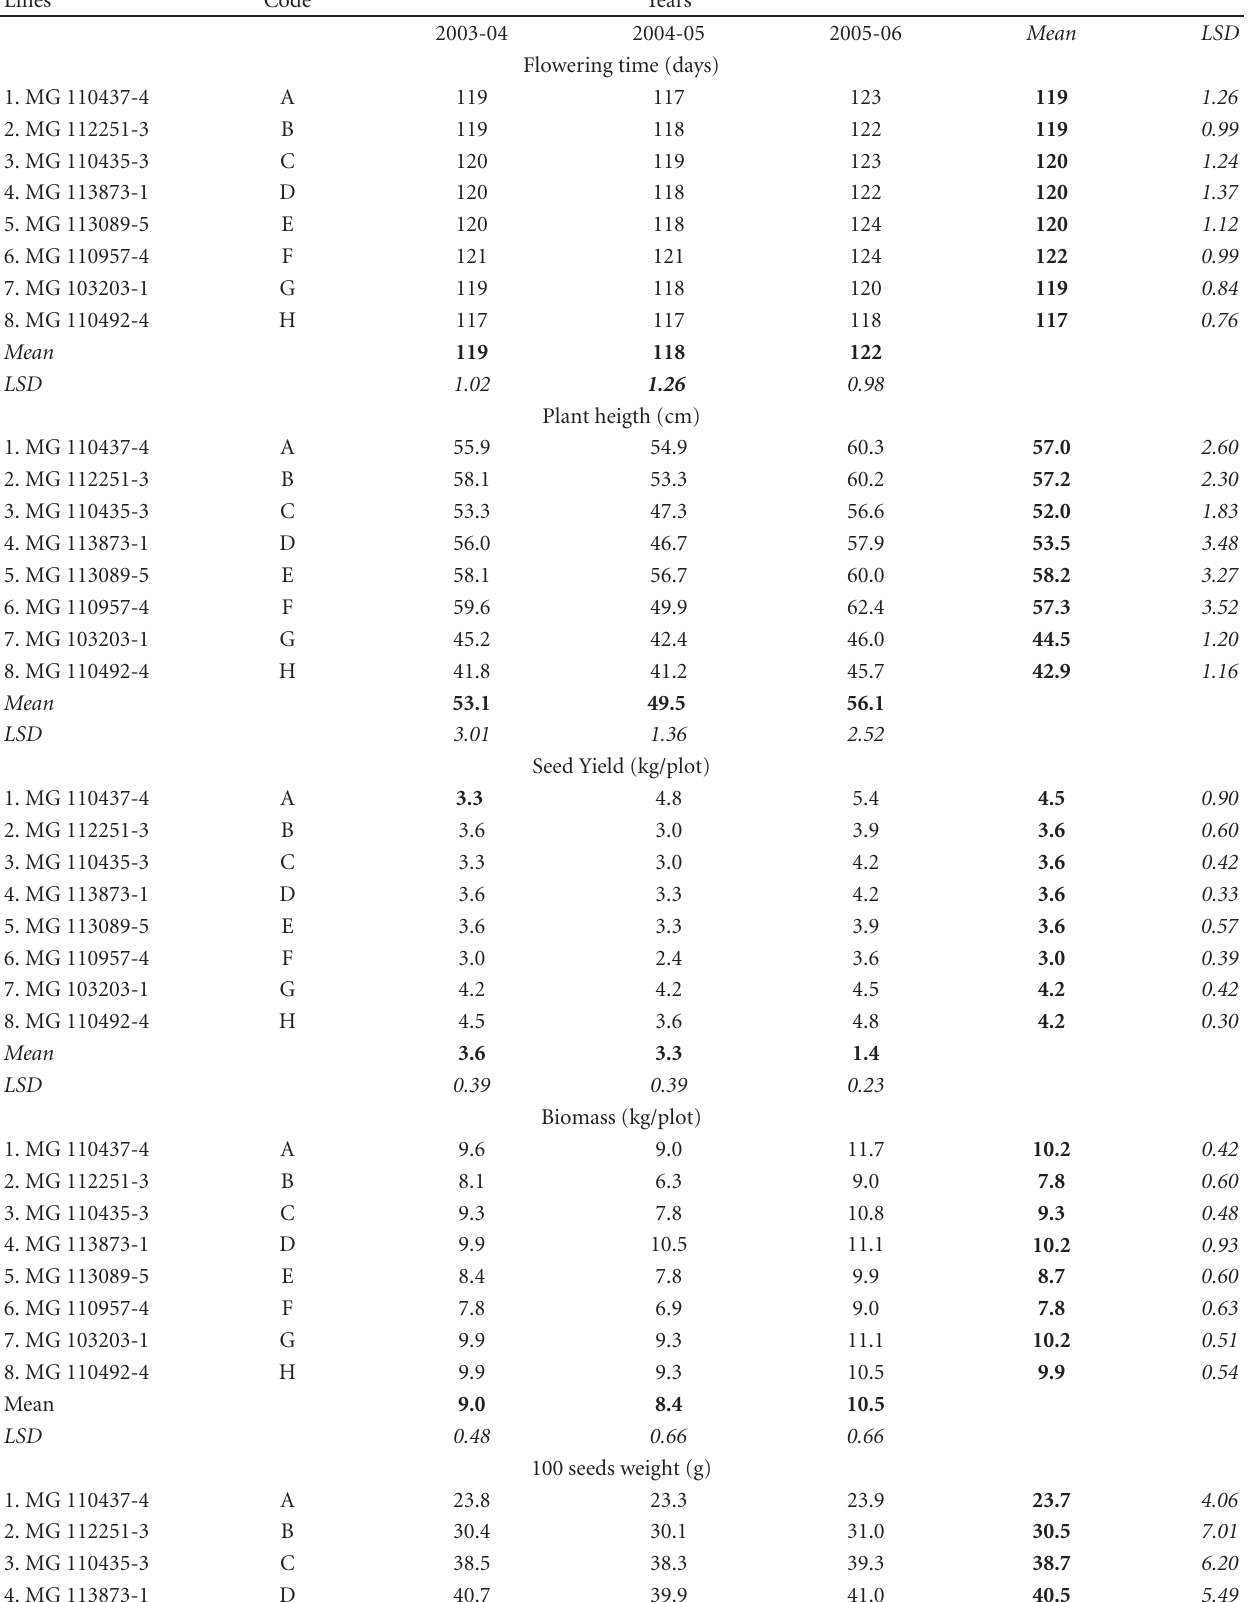
Table 1: Means and LSD for five characters observed in 8 grass pea ( Lathyrus sativus L.) lines over three consecutive years (2003–2006).